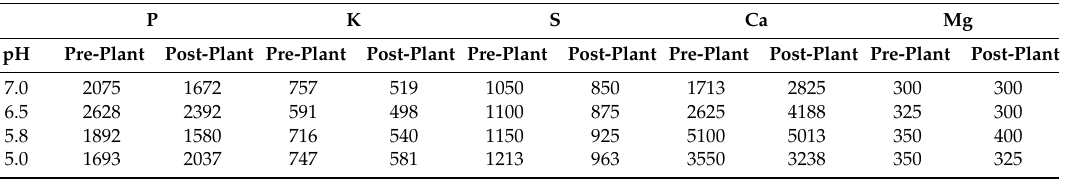
Table 10. Macronutrients (mg · kg dried solids − 1 ) contained in suspended solids of aquaculture effluent z . P K S Ca Mg pH